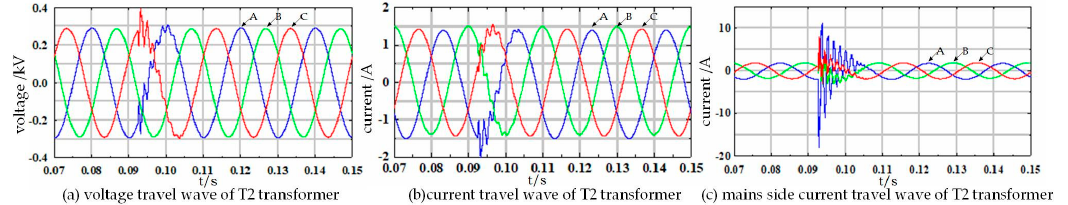
Figure 4. Traveling waves of voltage and current at different points.